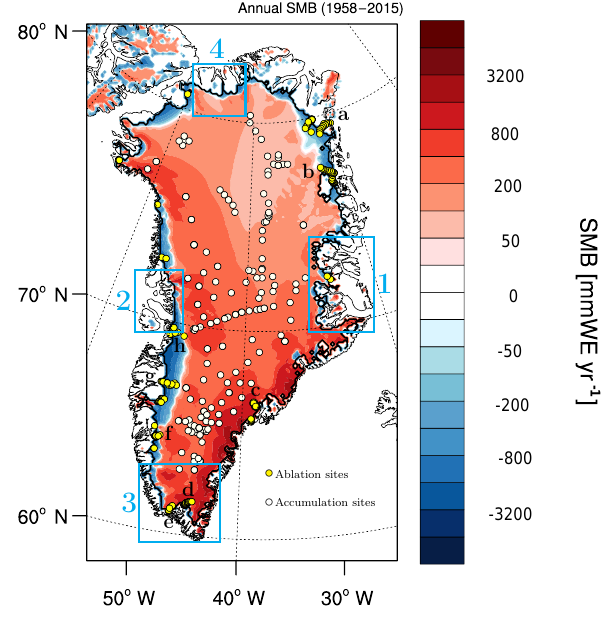
Figure 1. Annual mean SMB modelled by RACMO2.3 at 11km over the GrIS and surrounding ice caps for the period 1958–2015. This figure also depicts the location of 213 ablation measuring sites (yellow dots) and 182 accumulation sites (white dots) used for downscaled SMB evaluation as well as the four GrIS marginal re- gions (blue boxes), discussed in Sect. 5. Letters refer to the different transects shown in Fig.